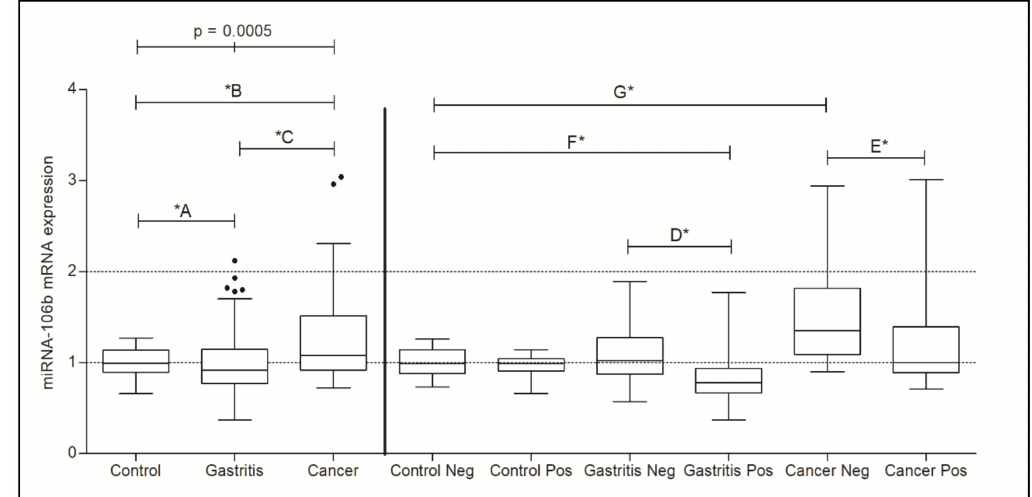
Figure 4. Analysis of miR-106b-5p gene expression not considering the presence of H. pylori in Control, Gastritis, and Cancer groups as well as analysis of miR-106b-5p gene expression with the presence of H. pylori . Legend: Neg.: Negative; Pos.: Positive. * statistically significant and p -values showed in Table